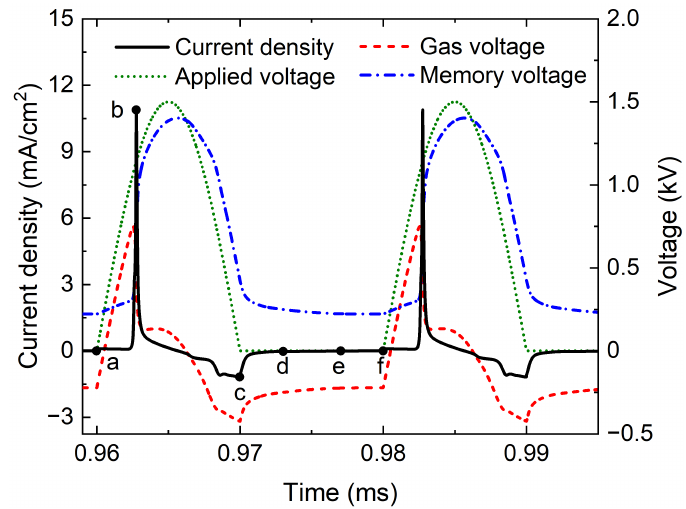
Figure 4. Temporal evolutions of current density, applied voltage, gas voltage, and memory voltage in P1 discharge with a gap width of 4.0